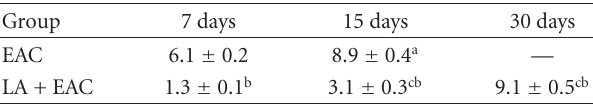
Table 3: E ff ect of 50mg/kg body wt. α -lipoic (LA) (daily admin- istration) on the volume (mL) of Ehrlich ascites carcinoma (EAC) cells in